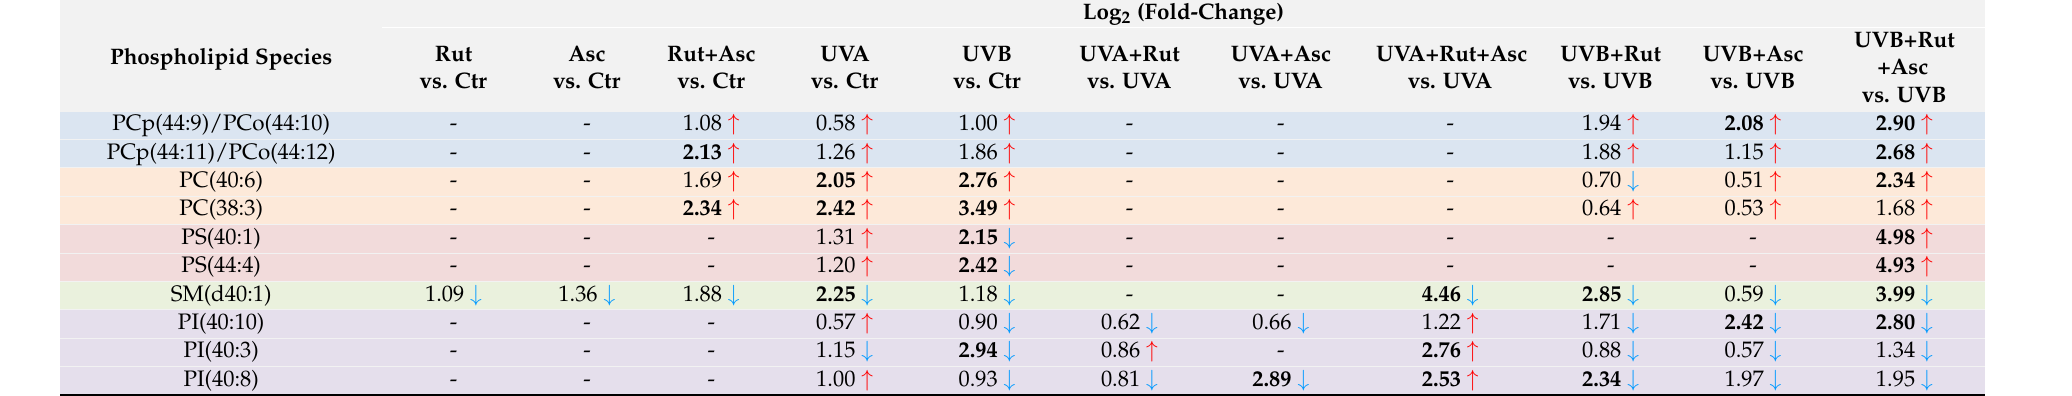
Table 1. The alteration observed in the molecular species of the 10 phospholipid molecular species (selected from 25 most discriminating phospholipid molecular species according to one-way ANOVA and Tukey’s post-hoc tests) in the 3D cultured fibroblasts comparing control (Ctr) with rutin (Rut (25 µ M)), control with ascorbic acid (Asc (100 µ M)), control with Rut+Asc, UVA with Rut, UVA with UVA+Asc, UVA with UVA+Rut+Asc, UVB with Rut, UVB with UVB+Asc, and UVB with UVB+Rut+Asc, along with their respective fold change. All the alterations are significant at the p < 0.05 level. The bold indicates high fold change (more than 2-fold); red arrows indicate the increased level; blue arrows indicate the decreased level; -, not significant changes. The table with the 25 most discriminating phospholipid molecular species is included in Supplementary Materials (Supplementary Table S3).